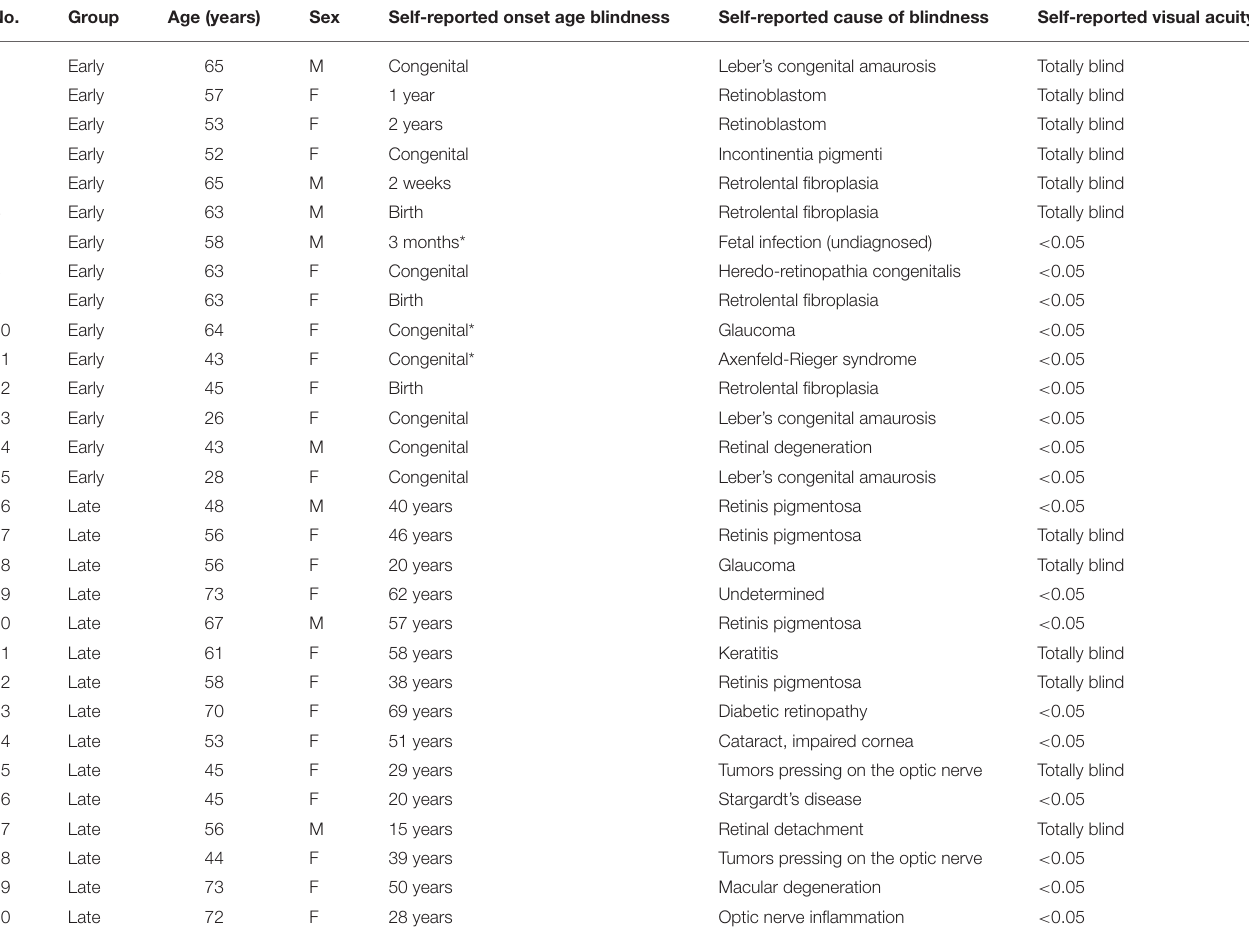
TABLE 1 | Blind participants’ group belonging, age, sex, and self-reported onset age of blindness, cause of blindness, and current visual acuity.